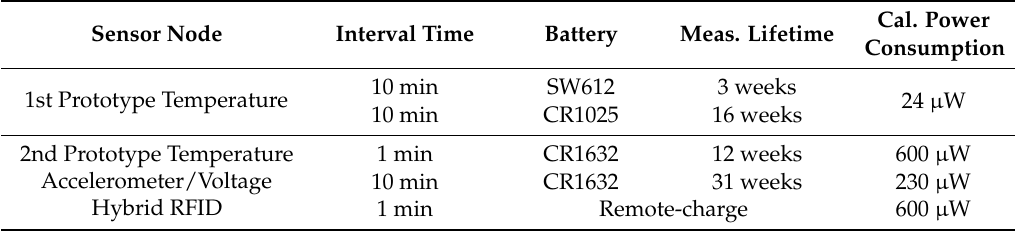
Table 1. Measured battery lifetime and calculated average power consumption of the developed sensor nodes under various conditions.